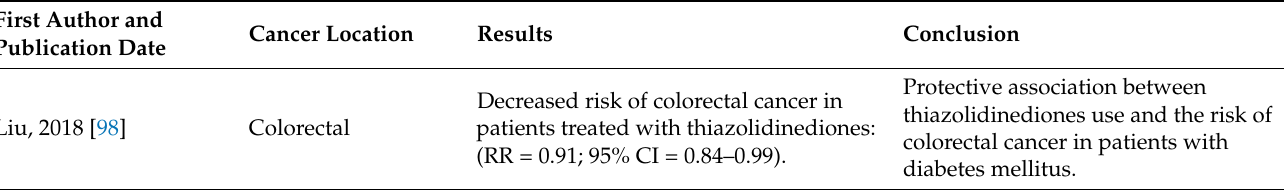
Table 3. Meta-analyses of the effect of thiazolidinediones on the risk of cancer in the last 5